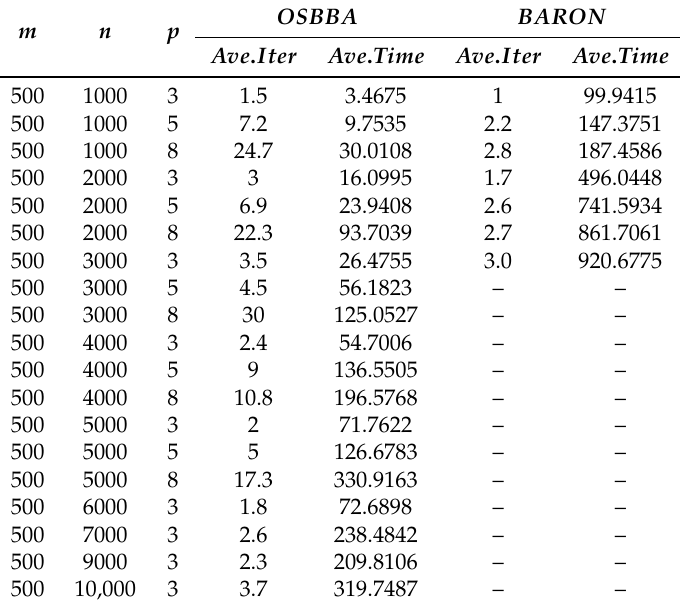
Table 9. The results of random calculation for example